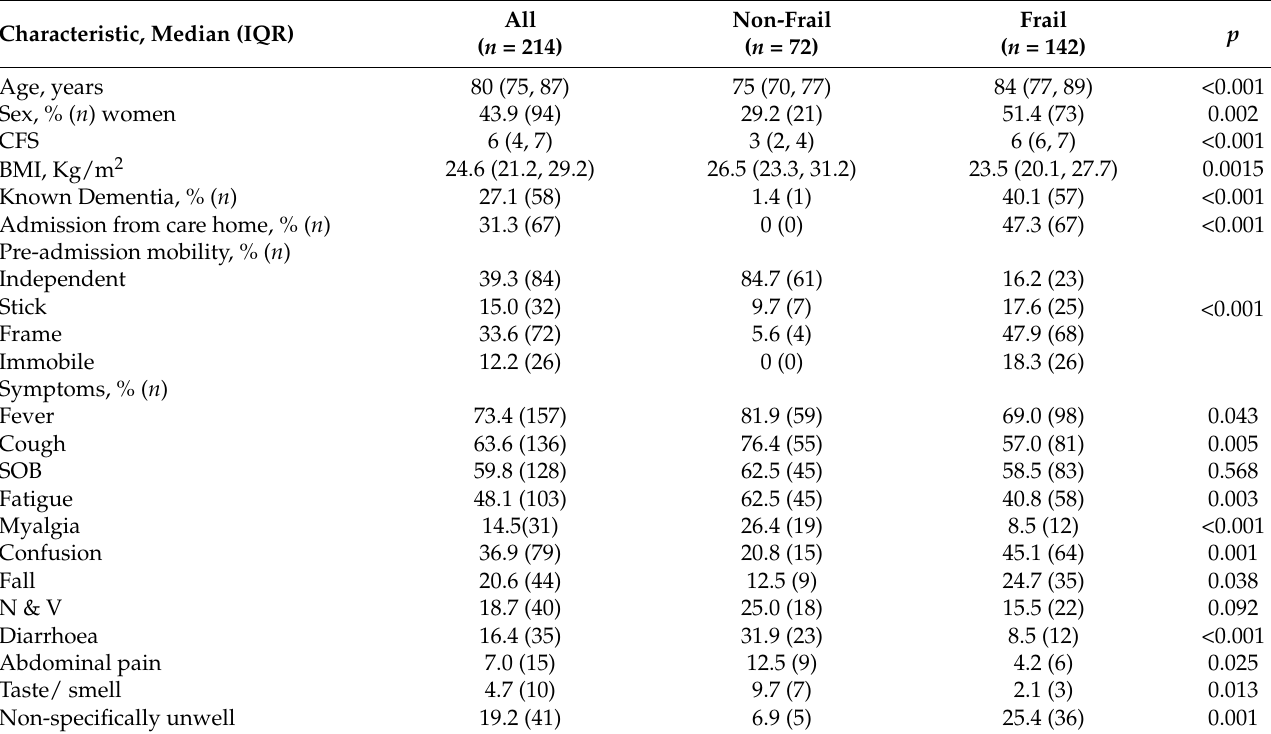
Table 1. Characteristics of the whole cohort and by frailty (CFS 1–4 “Nonfrail” versus CFS 5–8